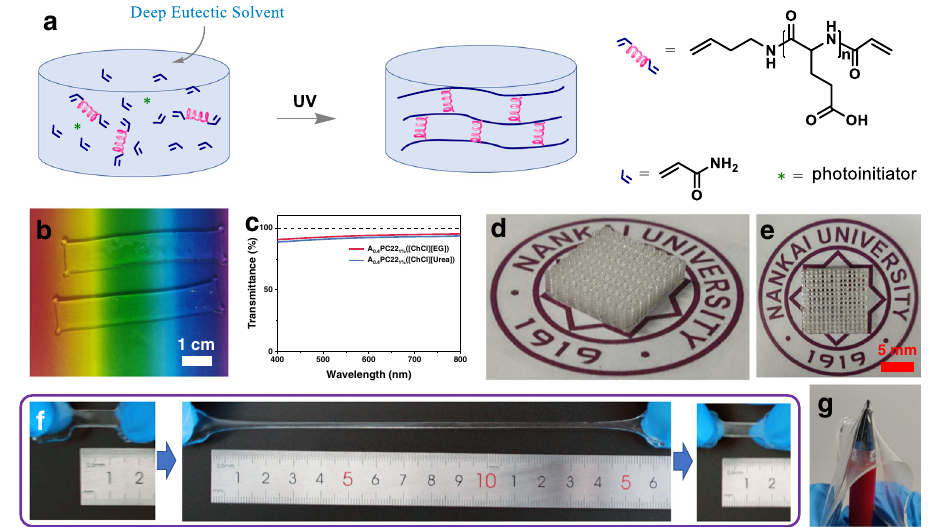
Fig. 2 | Synthesis and characterizations of peptide-enhanced eutectogel. a Dissolving monomer, PC and photo-initiator in DES followed by photo- polymerization. b Photograph and c transmission spectra of the two